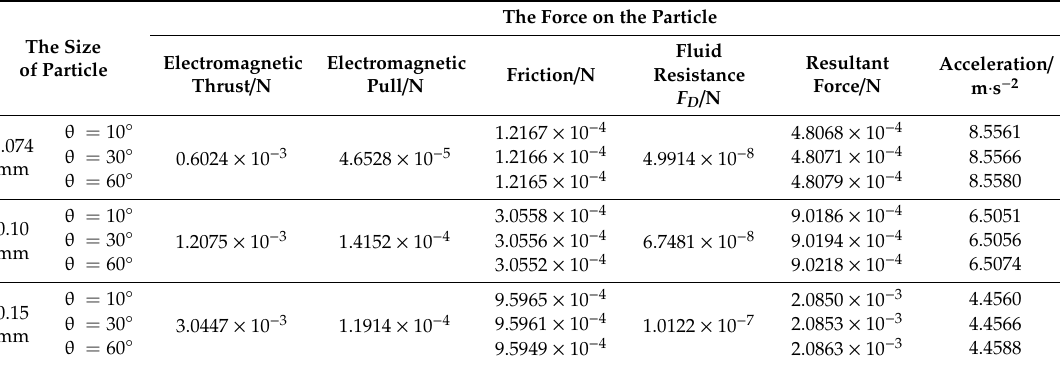
Figure 13. Force analysis of magnetic particles. Table 8. Various forces acting on magnetic particles.